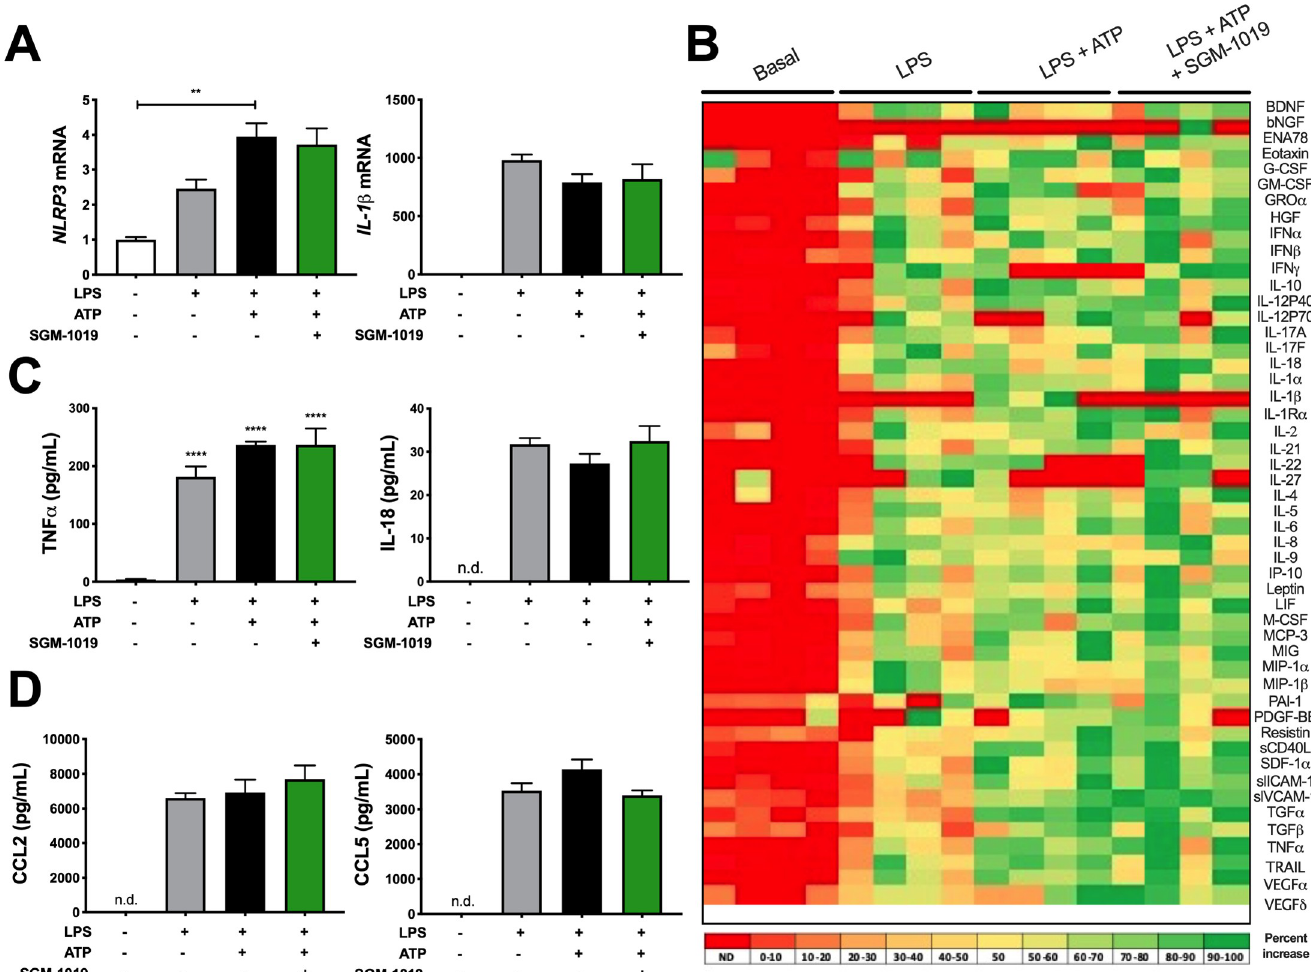
Fig 5. Inhibition of P2RX7 alters the secretion of cytokines in KCs. (A) Relative expression of NLRP3 and IL-1 β , (B) Heat map showing levels of cytokines and growth factors, (C) IL-18 and TNF α levels, and (D) CCL2 and CCL5 chemokine levels present in the culture media from KCs treated with LPS, ATP ± SGM-1019. In heat map, red indicates low relative expression, and green indicates high relative expression. n.d., for not detected. In all statistical plots, the data are shown as the mean ± SEM. � P � 0.05, �� P � 0.01, ��� P � 0.001, ���� P � 0.0001 by one-way ANOVA.